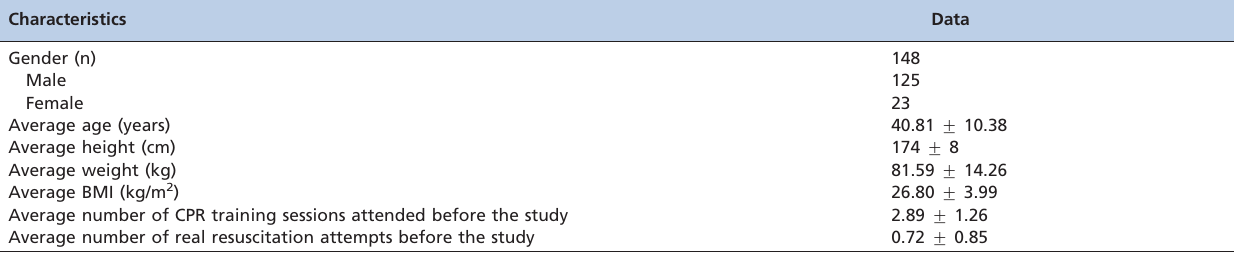
Table 1 - Baseline data for the study participants.